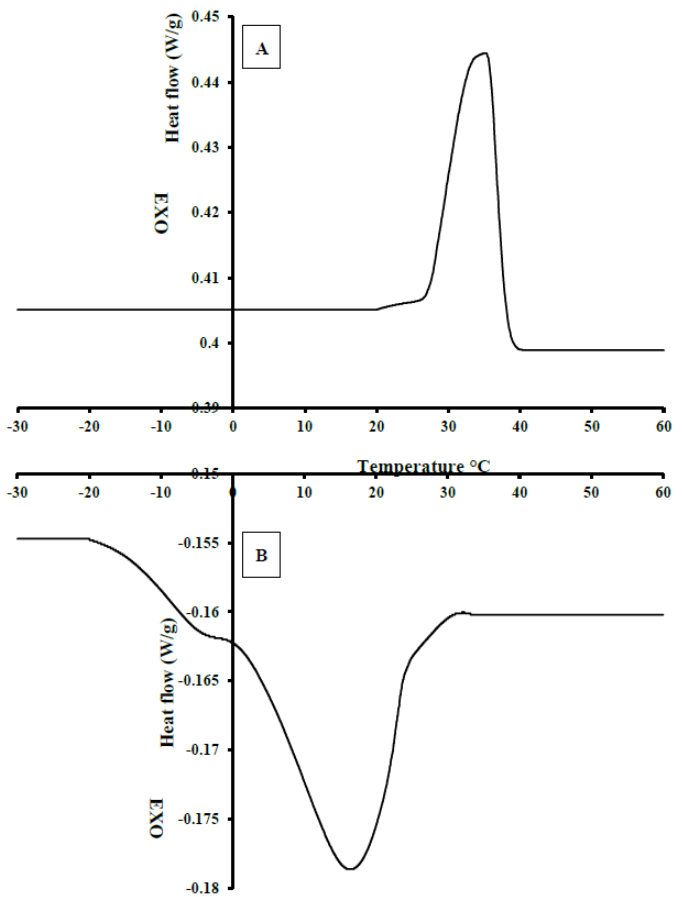
Figure 6. Differential scanning calorimeter (DSC) thermograms of CTO ( A ) Melting curve ( B ) Crystallization curve. Table 2. T onset , T peak and Δ H values obtained from melting, crystallization and heat capacity of CTO. Characteristics